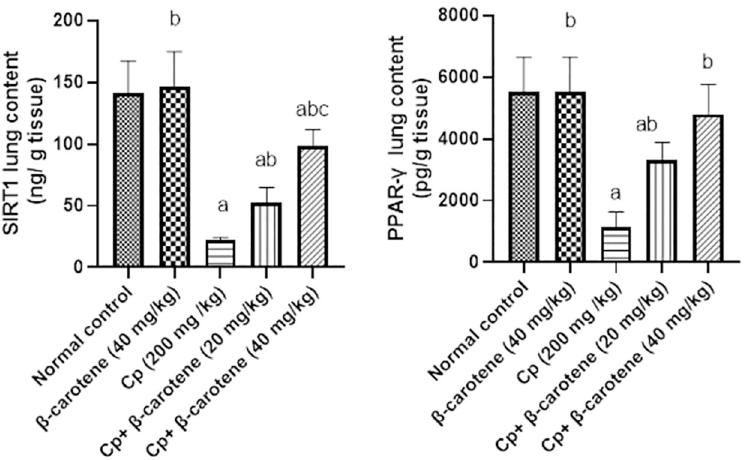
Fig 7. Effect of β -carotene on SIRT1 and PPAR γ lung contents. a Significantly different from the control group. b Significantly different from the CP group. c Significantly different from the CP + β -carotene 20 mg/kg group at P < 0 . 05